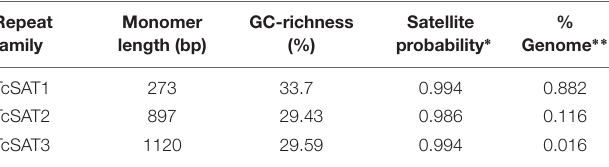
TABLE 4 | Characterization of satellite DNA families TcSAT1, TcSAT2, and TcSAT3 in T. cinerariifolium genome.